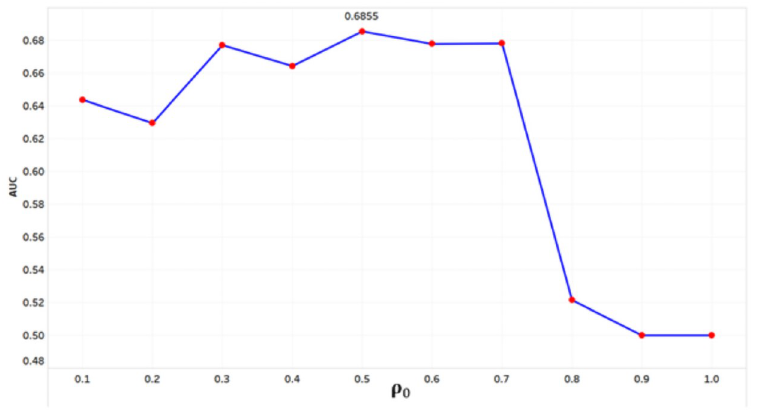
Fig 2. Test AUC variation with initial ρ 0 .